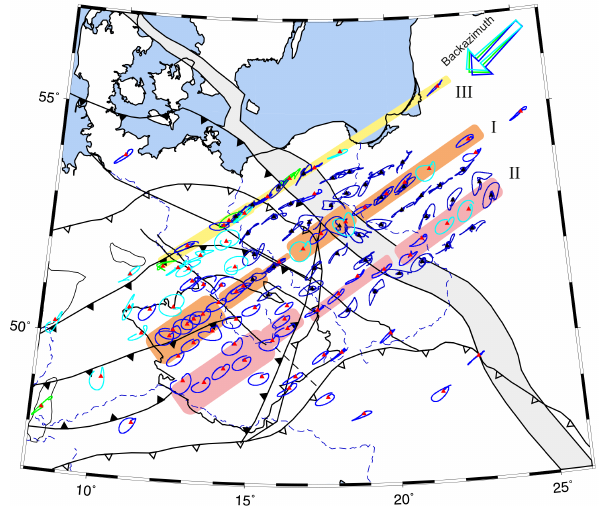
Figure 10. Azimuth ϕ of the fast shear-wave polarizations and de- lay times δt evaluated for four events from the NW back azimuths. Green arrows represent results stacked for two events. Nulls or near- null splitting prevail in the BM and in the western part of the array, whereas stations east of the Moravian Line show strong anisotropic signal for this back-azimuth interval.